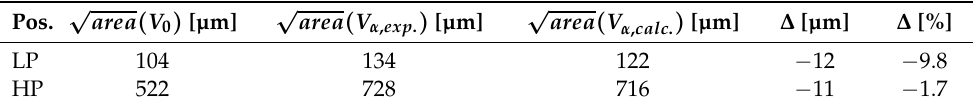
Figure 15. Relation between measured and calculated cumulative defect distributions. ( a ) Cumulative defect distributions of LP samples. ( b ) Cumulative defect distributions of HP samples. √ area -parameters for 50% probability of occurrence Table 7. Comparison of statistically evaluated considering the effect of